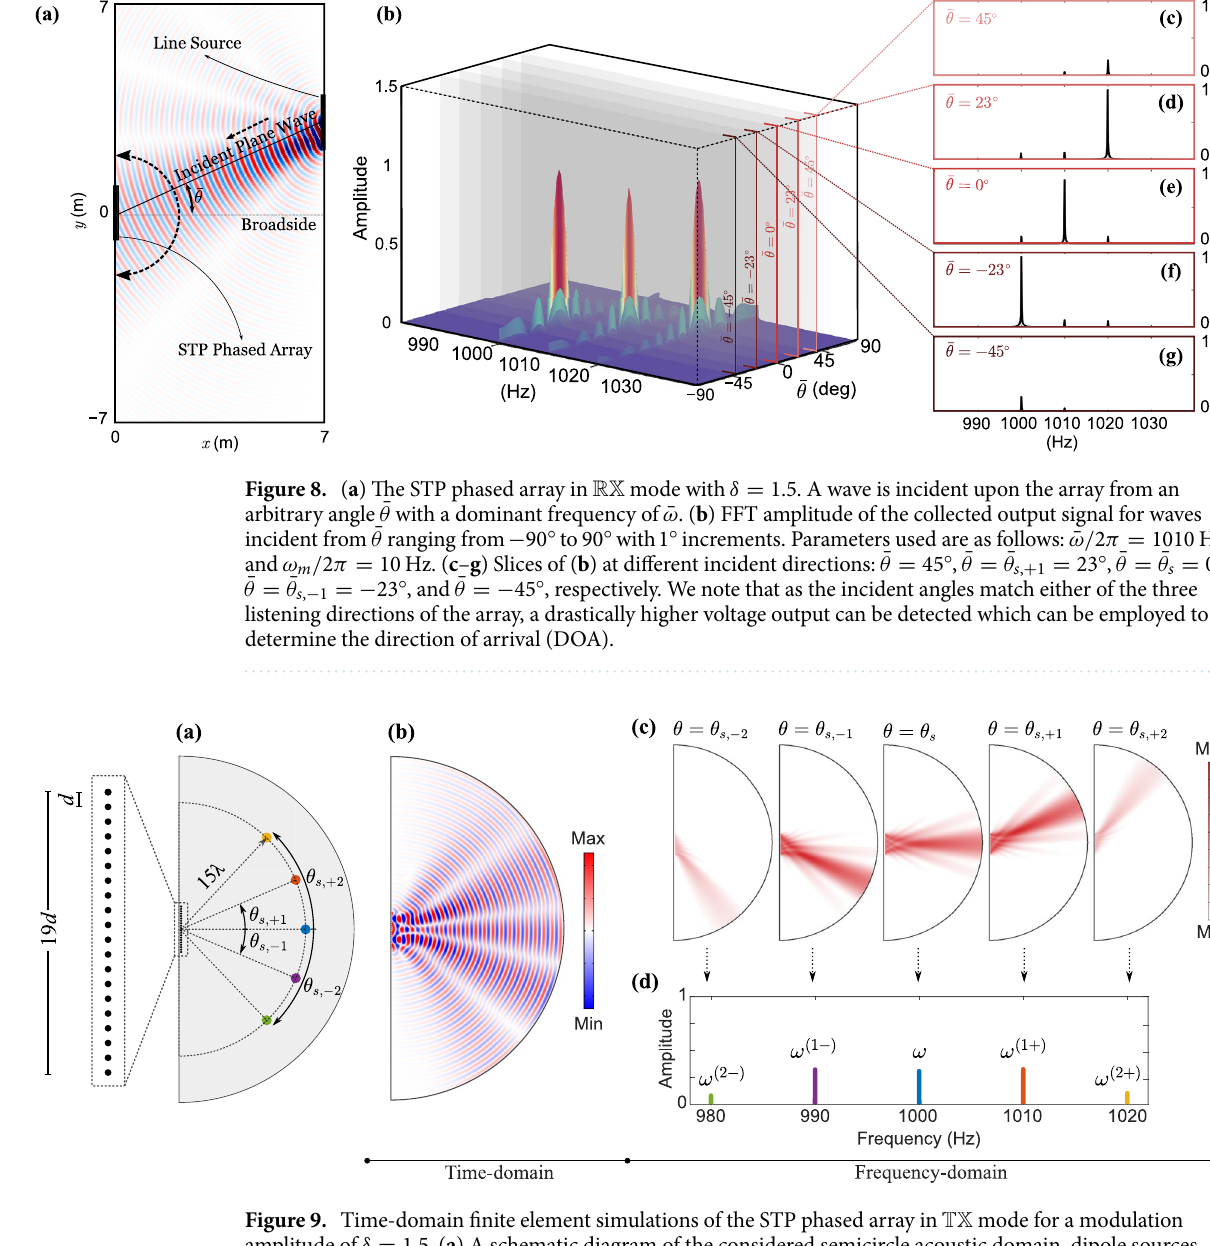
Figure 9. Time-domain finite element simulations of the STP phased array in TX mode for a modulation 1.5 . ( a ) A schematic diagram of the considered semicircle acoustic domain, dipole sources, amplitude of δ = 0.05 s with ω/ 2 π 1000 Hz and ω m / 2 π 10 Hz. ( c ) From left to and sensor locations. ( b ) Pressure field at t = = = right: Directional breakdown and distribution of the FFT amplitudes at 980 Hz, 990 Hz, 1000 Hz, 1010 Hz, and 1020 Hz. ( d ) Normalized frequency spectrum of the pressure amplitude for the five sensor locations shown in (cid:31) / 4 , and principal transmission directions are measured 343 mm, d ( a ). Parameters used are as follows: (cid:31) = = 0 55 24 23 52 at θ s , 2 1 1 2 ◦ , θ s , ◦ , θ s , ◦ , θ s = ◦ , and θ s , ◦ = − = − = = − − + + are spaced at a quarter wavelength and used to create the linear STP phased array. The array is excited with the voltage signal given by Eq. (2). The same set of parameters listed earlier were used here. A schematic of the 857.5 mm in length. model is depicted in Fig. 9a, which includes two spatial super cells, each measuring 10 d = Starting with the TX mode, the pressure field of the STP phased array is depicted in Fig. 9b, exhibiting five different transmission channels for the generated components. In Fig. 9c, the transient results are post- processed and a series of FFTs are computed which break down the frequency content of these wave com- 1000 Hz, the first ponents into various TX channels. The fundamental wave component is observed at ω 2 π = ( 1 ) 1010 Hz, the first down-converted at ω ( 1 − ) 990 Hz, the second up-converted at + up-converted at ω 2 π = 2 π = ω ( 2 + ) 1020 Hz, and the second down-converted at ω ( 2 − ) 980 Hz, which approximately propagate along 2 π = 2 π =